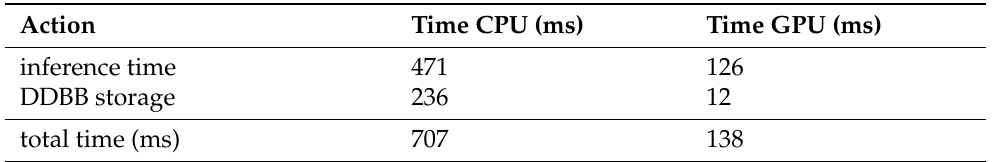
Table 9. Processing